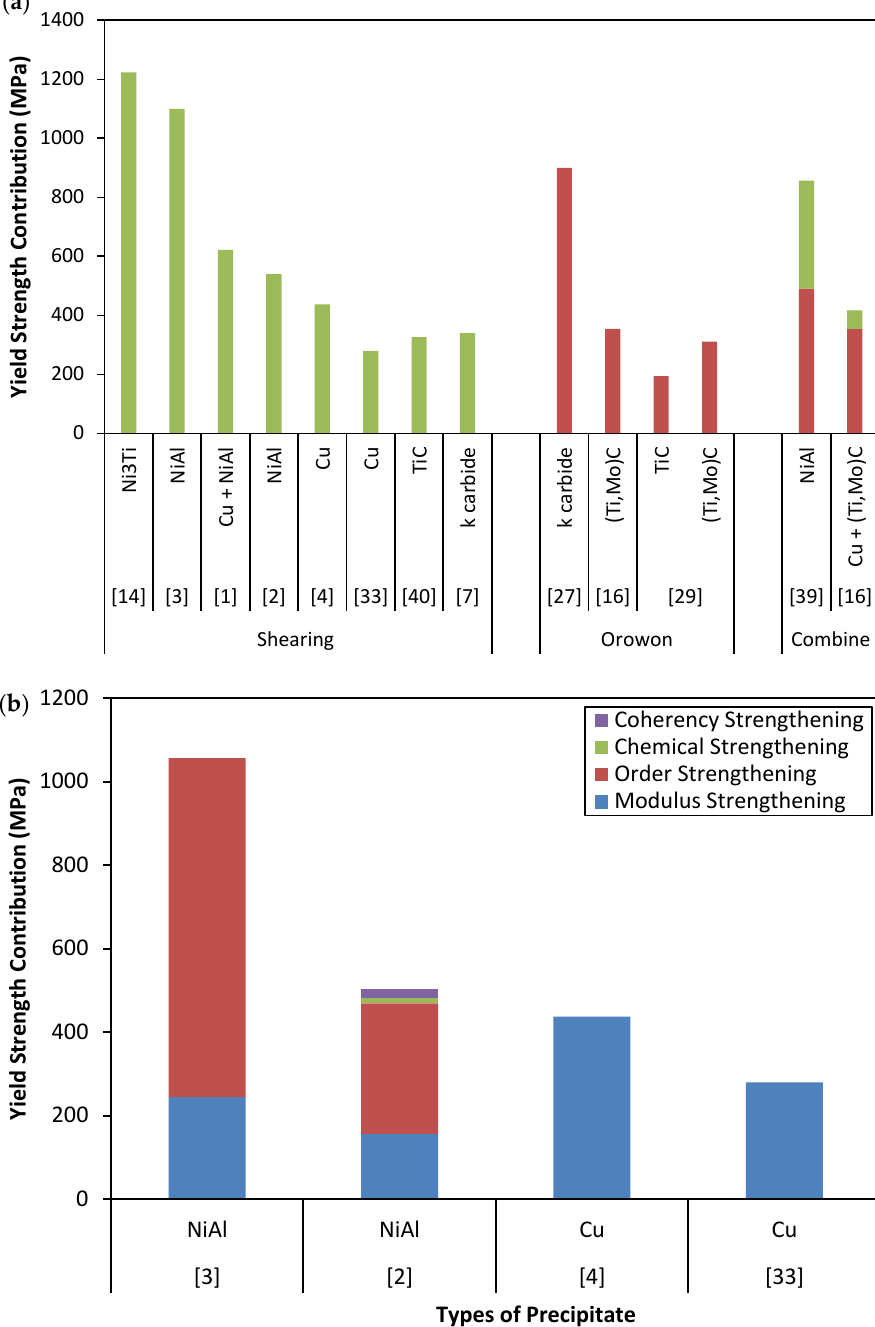
Figure 4. ( a ) The yield strength contribution of steels strengthened by various precipitates through different mechanisms; ( b ) The breakdown of strength contribution due to different interactions between dislocations and shearable precipitates.